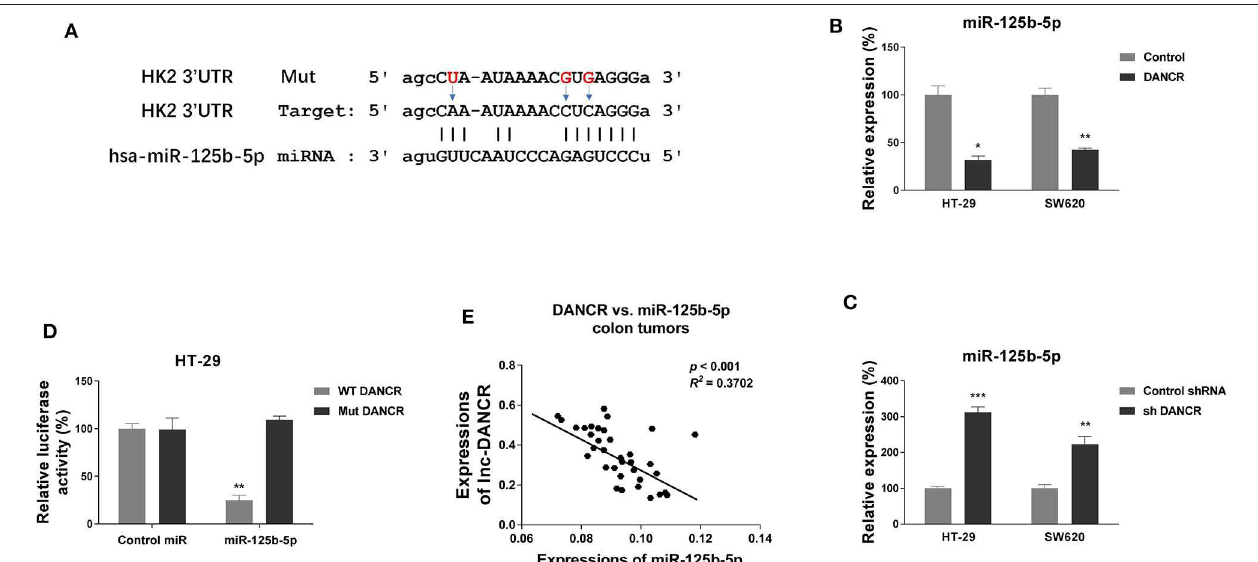
FIGURE 2 | LncRNA DANCR suppresses miR-125b-5p expression via sponging it as a ceRNA. (A) Prediction of binding sites of DANCR on miR-125b-5p, as well as the binding sites mutants of DANCR. (B) HT-29 and SW620 cells were transfected with control or DANCR overexpression vector for 48h. The expressions of miR-125b-5p were detected by qRT-PCR. (C) HT-29 and SW620 cells were transfected with control shRNA or DANCR shRNA for 48h. The expressions of miR-125b-5p were detected by qRT-PCR. (D) HT-29 cells were cotransfected with luciferase reporter vectors containing WT-DANCR or Mut-DANCR and control miR or miR-125b-5p. The relative luciferase activity was measured by luciferase assay. (E) Negative correlation between DANCR and miR-125b-5p expressions was observed from colon cancer tissues. Data are presented as mean ± SD. * p < 0.05, ** p < 0.01, and *** p <